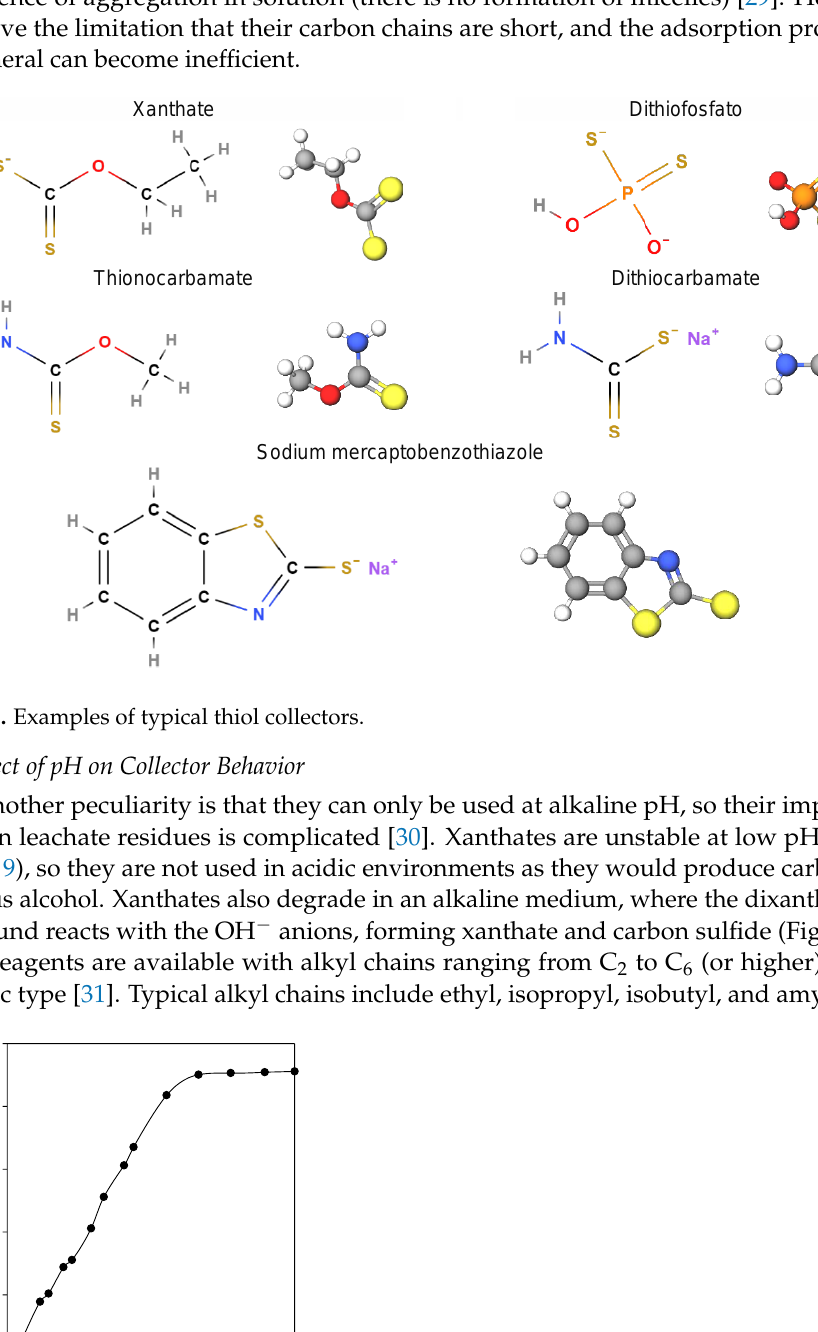
improving their